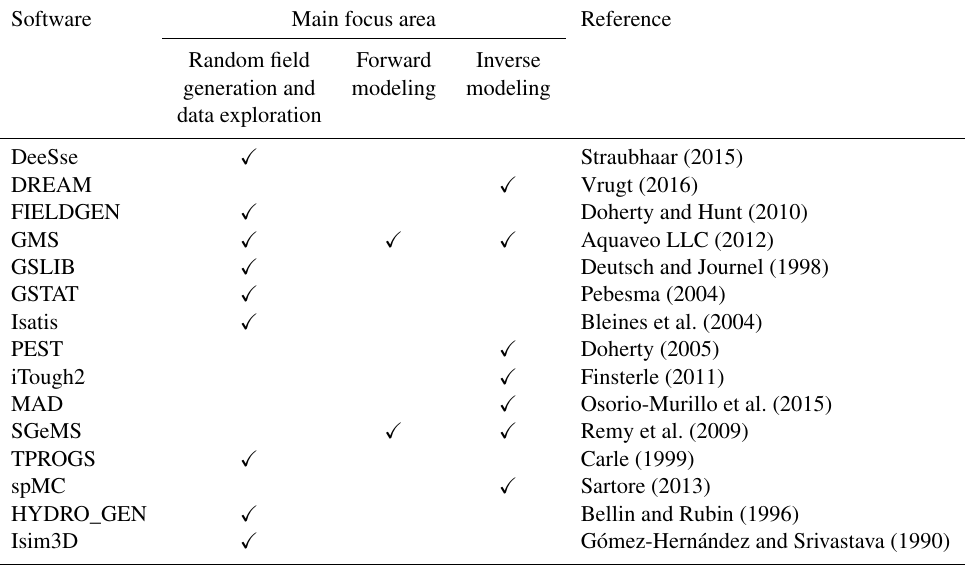
Table 1. Application areas of reviewed stochastic hydrogeology software.